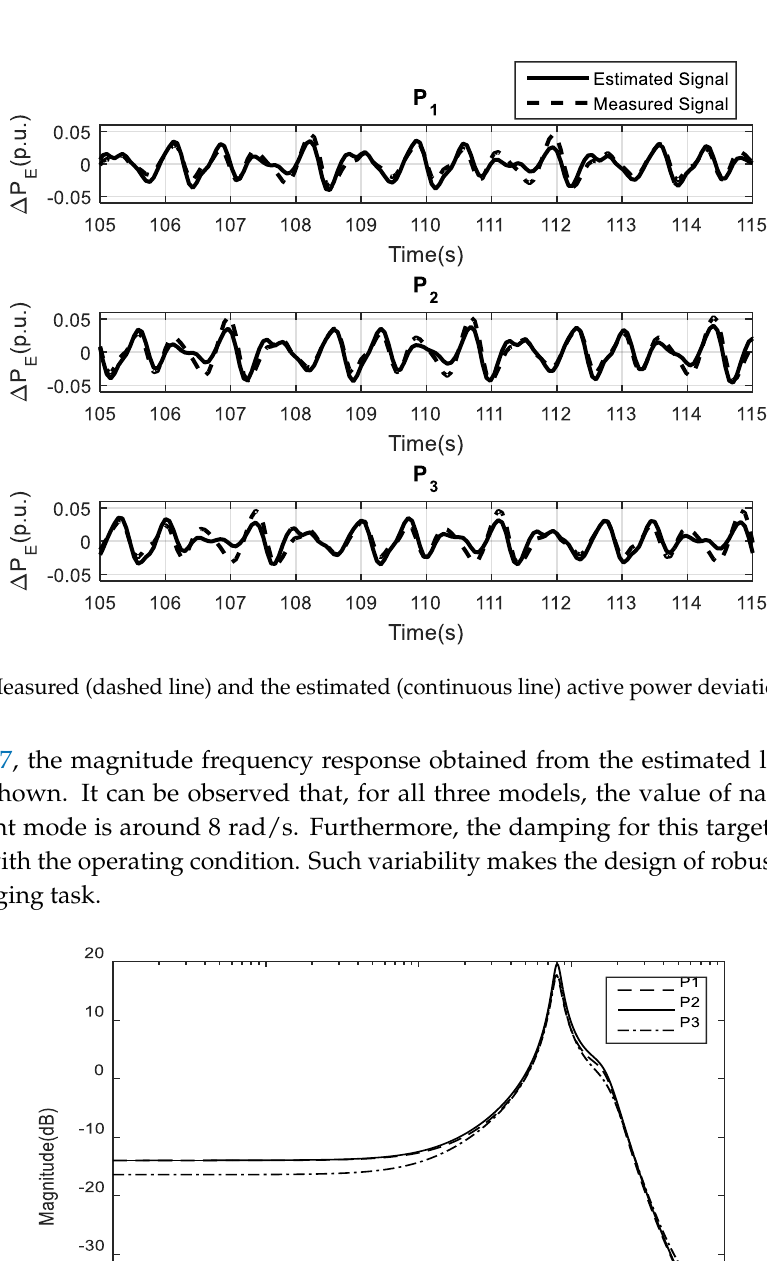
Table 3. Relative Damping and Natural Frequencies for Eigenvalues of the Identified Local Models.